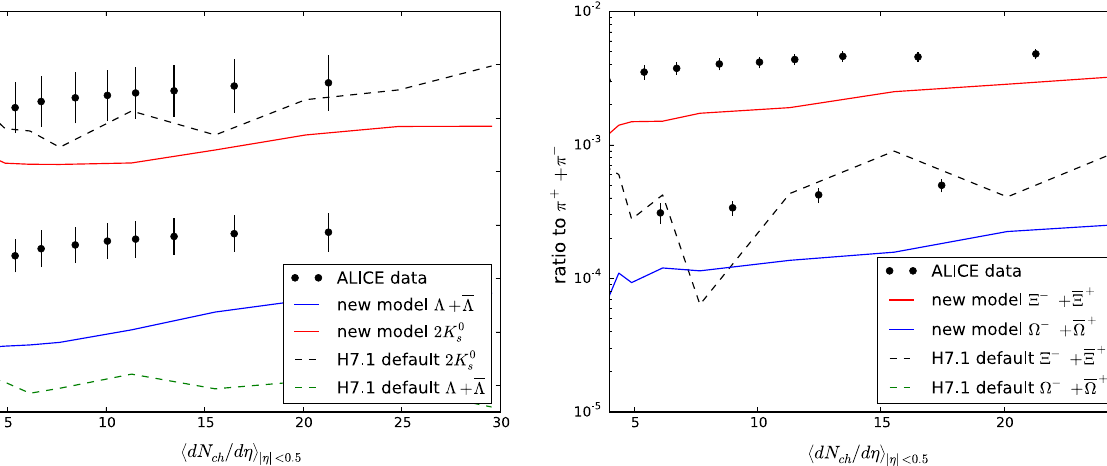
and the (cid:7) − /(cid:6) p ⊥ distribution as measured by CMS at S